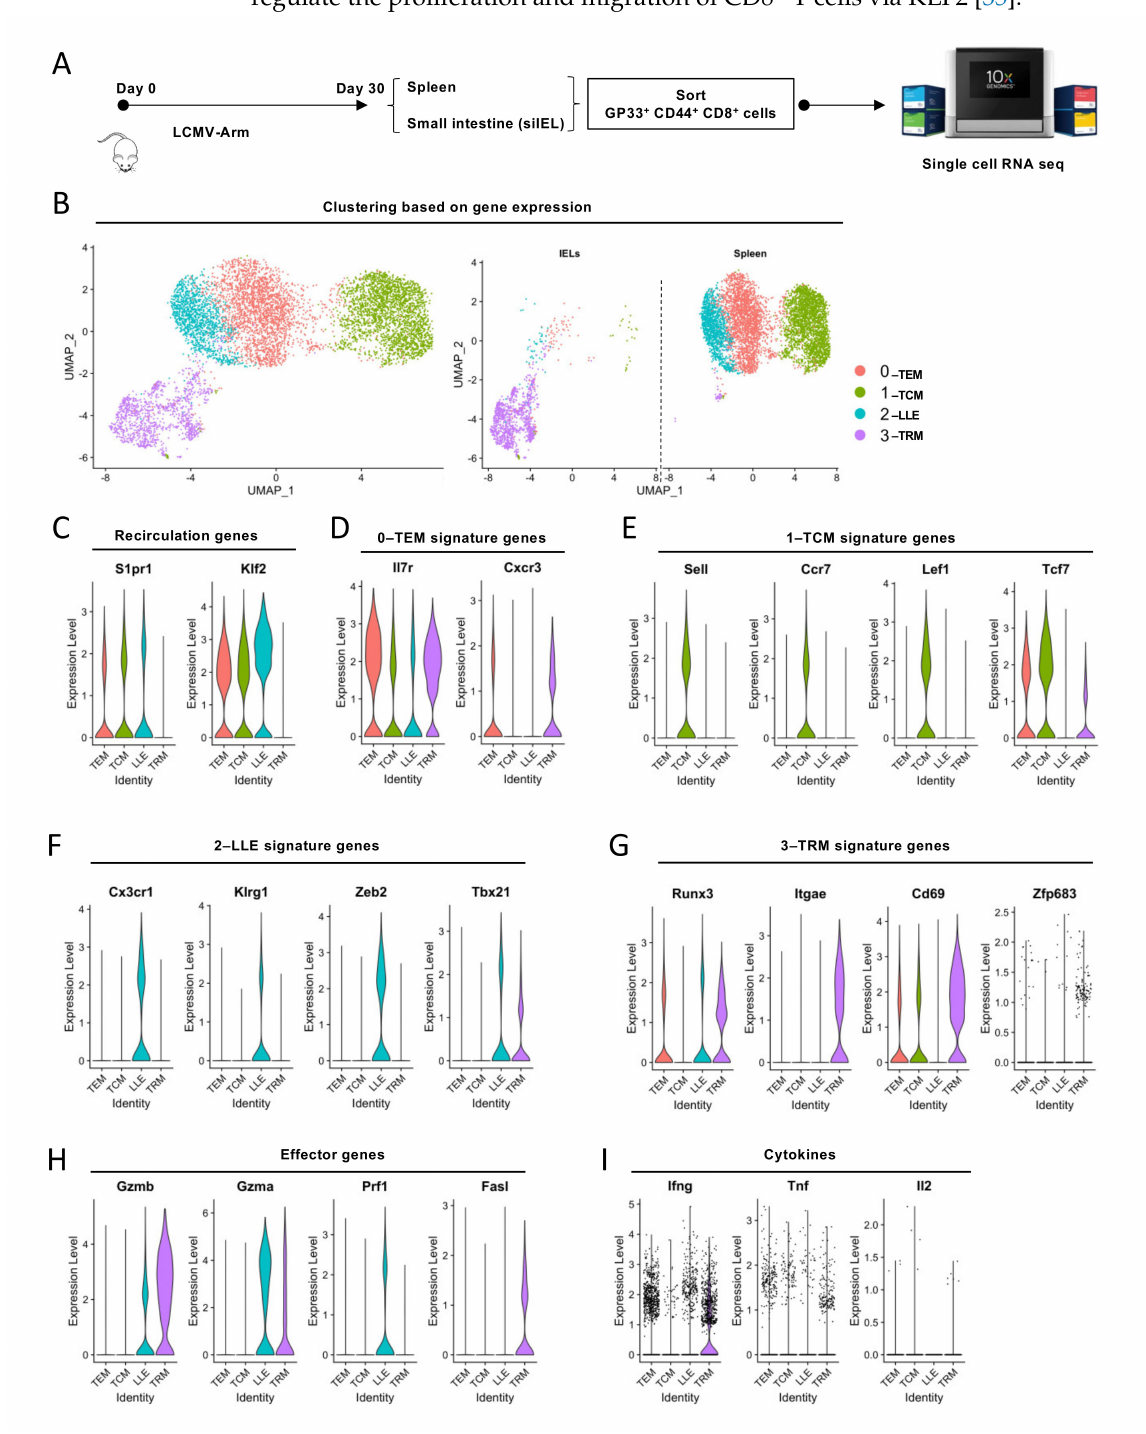
Figure 1. Single-cell transcriptomics probes heterogeneity within memory CD8 + T-cell populations: ( A ) Schematic of experi- mental set-up. Mice were infected with 2 × 10 5 PFU/mouse LCMV Armstrong. On day 30 post-infection, GP33 + CD44 + CD8 + cells were FACS-sorted from spleen and siIEL. scRNA-seq libraries were generated using the 10 × Genomics platform. ( B ) Unsupervised clustering based on gene expression identified four major populations when visualized by UMAP. Left, combined scRNA-seq datasets from spleen and siIEL. Right, cells from different tissues. ( C – I ) Violin plots showing the expression of signature genes of different memory subsets and genes related to migration, effector function, and cytokines, as well as signature genes of the three major memory T-cell